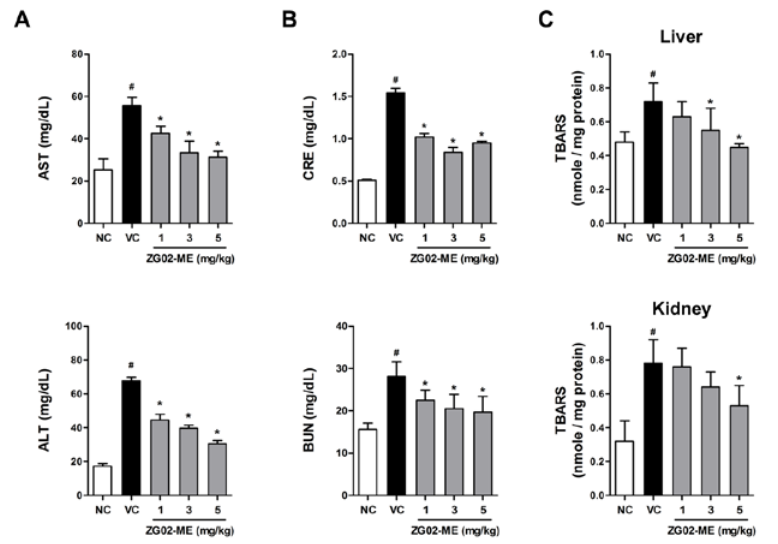
Figure 3. The effects of ZG02-ME treatment on AST, ALT, creatinine, BUN, and TBARS in diabetic-obese ( db / db ) mice. The db / m mice were intragastrically administrated daily with normal saline containing 0.01% DMSO, as the vehicle, for four weeks (normal control, NC). The db / db mice were intragastrically administrated daily with vehicle (vehicle control, VC) or ZG02-ME (1, 3, 5 mg/kg body weight), respectively, for four weeks.